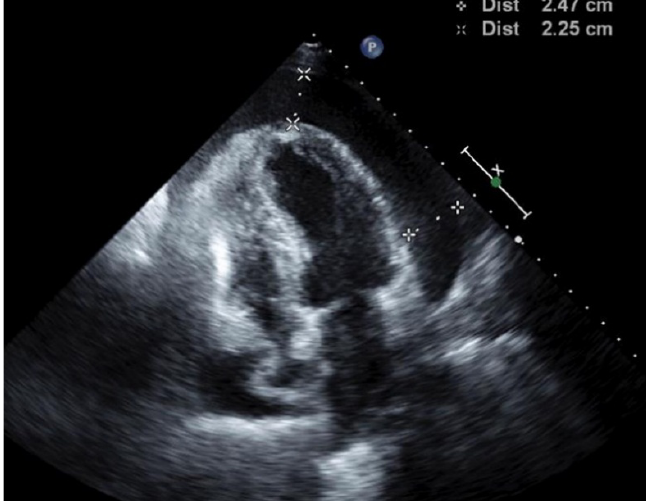
Figure 2. Transthoracic echocardiogram. Large pericardial effusion, right atrial and ventricular diastolic collapse consistent with cardiac